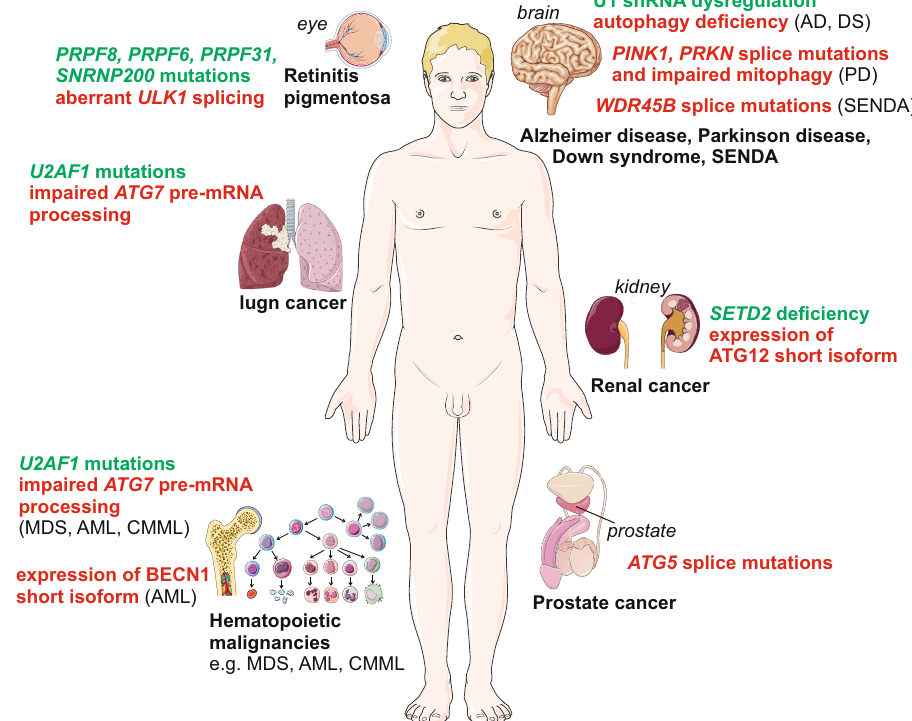
Fig. 4 Human diseases associated with alternative-splicing dependent autophagy impairment. For details, see text body. In brief, U1 snRNP enrichment in familial Alzheimer disease (AD) and Down syndrome (DS) are associated with impaired autophagy. De novo WDR45/WIPI4 splice mutations and lowered autophagic fl ux are associated with static encephalopathy of childhood with neurodegeneration in adulthood (SENDA). Splicing mutations in PINK1 and PRKN / PARKIN lead to mitophagy impairment and contribute to PD and various cancer. Aberrant alternative splicing of ULK1 and impaired mitophagy associated with PRPF8 , PRPF6 , PRPF31 and SNRNP200 mutations contribute to retinitis-pigmentosa. U2AF1 -mutation dependent ATG7 expression reduction, due to impaired pre-mRNA processing, in hematopoietic cells promotes autophagy impairment and oncogenic transformation, as observed in myelodysplastic syndrome (MDS), acute myeloid leukemia (AML), and chronic myelomonocytic leukemia (CMML) as well as lung adenocarcinoma. BECN1 short isoform generated by alternative splicing acts as a negative modulator of autophagy in AML. De fi ciency in SETD2 , an epigenetic regulator of alternative splicing, promotes the expression of an ATG12 short isoform and alteration of autophagic fl ux in renal cancer. Splice-site mutations in ATG5 lead to a dysregulation of autophagy in prostate cancer. Images from Servier Medical Art (smart.servier.com) licensed under a Creative Commons Attribution